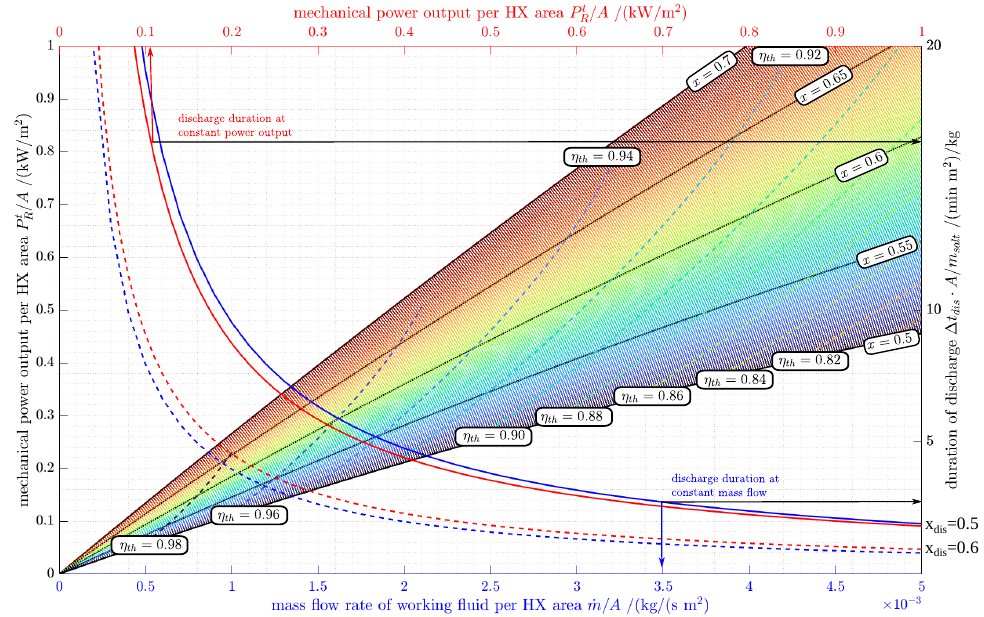
Figure 12. Operation map of the discharging process for the parameters reflected in Table 3. One color of the rainbow corresponds to a certain salt mass fraction of the solution and thus to a certain state of charge of the storage. It shows the power output on the left abscissa over mass flow rate on the bottom ordinate for this specific state of charge. The larger the mass flow rate at a certain salt mass fraction is, the larger the mechanical power output is. Colored dashed lines of constant thermal efficiency η th are additionally shown in the rainbow. The thermal efficiency rises with the salt mass fraction and declines with the mass flow rate. The blue lines show the discharge time for different constant vapor mass flows (bottom ordinate), and the red lines show the discharge times for constant power outputs (top ordinate). The full lines represent a full discharge ( x = 0.7 − 0.5) and the dashed lines, a half discharge ( x = 0.7 −